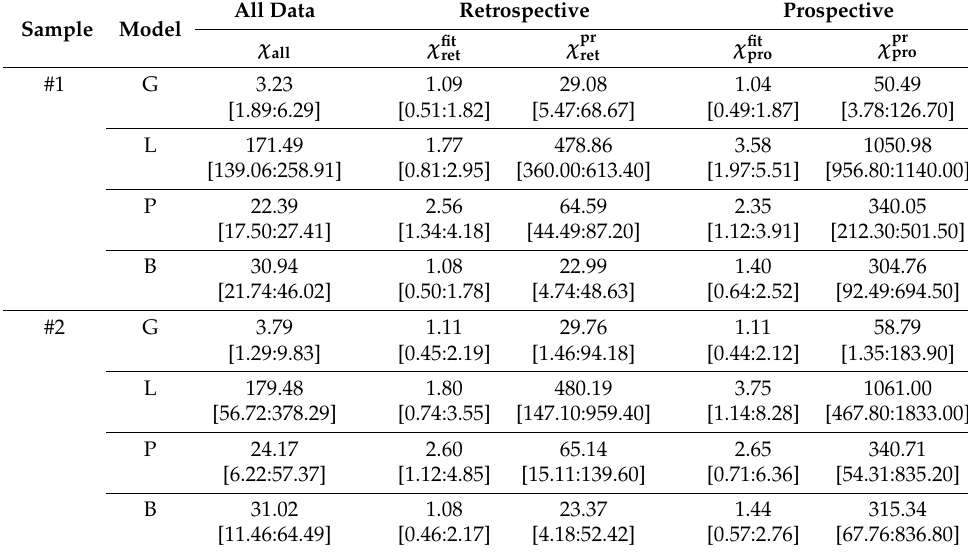
Table 1. Average values and 95% CI of the χ distributions obtained in the various fits carried out in the present